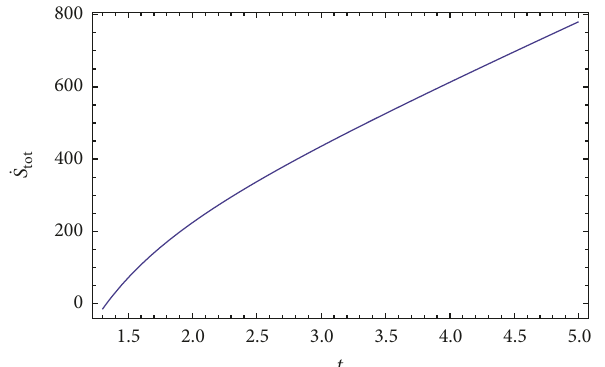
Figure 16: Plot of 𝑋 = at event